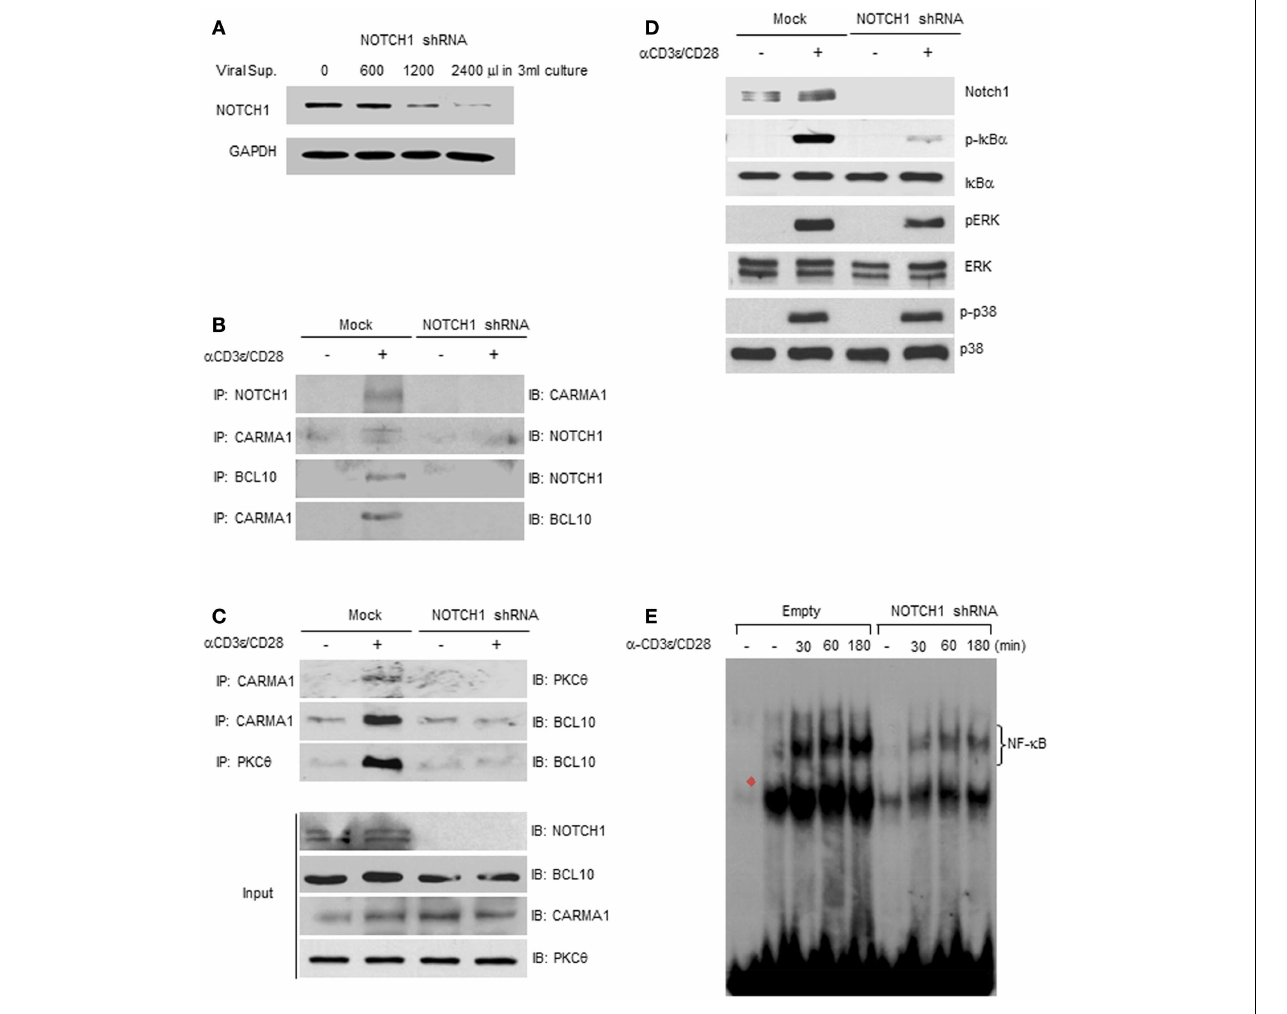
FIGURE 5 | NOTCH1 deficiency prevents the formation of the CBM complex . (A) NOTCH1 expression was efficiently reduced when JurkatT cells were incubated with viral supernatants. NOTCH1-knock-down JurkatT cells, or mock-infected control cells, were stimulated with plate-bound anti-human CD3 ε and anti-human CD28 for 1h, harvested for co-immunoprecipitation with indicated antibodies, then subjected to immunoblotting with (B,C) anti-NOTCH1, anti-CARMA1, anti-BCL10, or anti-PKC θ ; 1/100 of input was immunoblotted with indicated antibodies, or